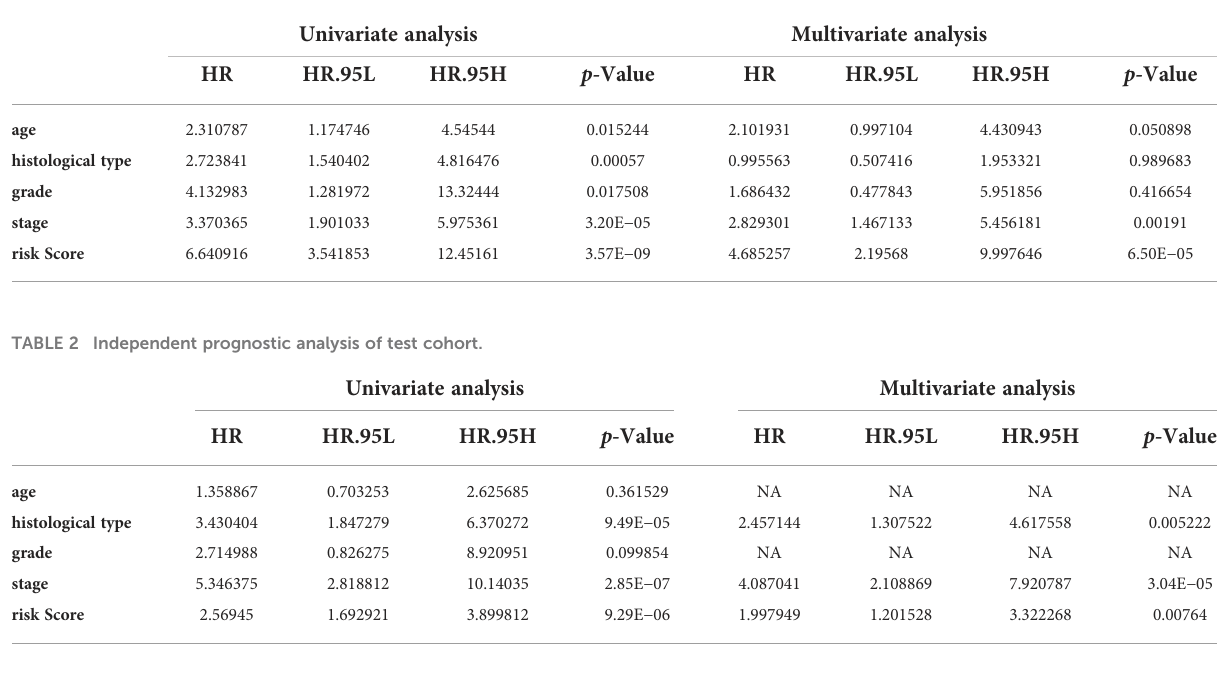
TABLE 1 Independent prognostic analysis of training cohort.